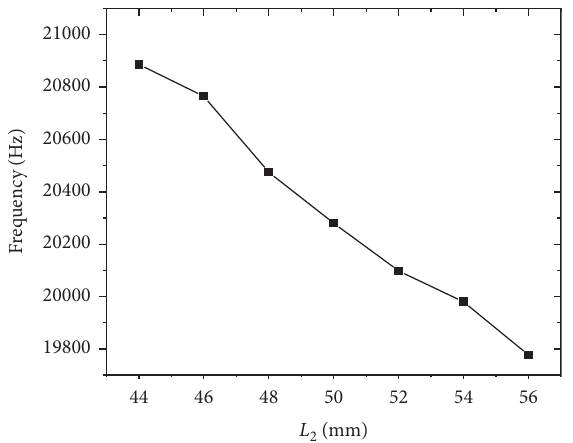
Figure 10: The effect of the length L 2 of the big end conical part of the compound horn on vibration frequency.